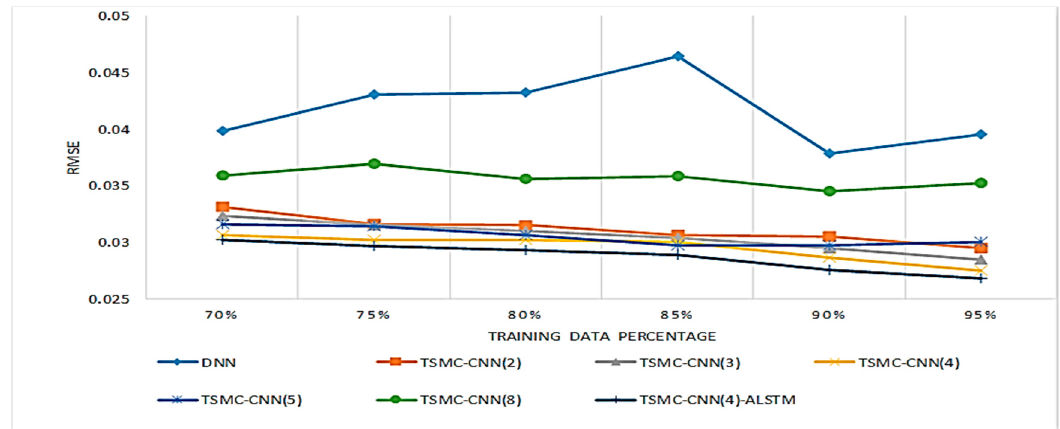
Figure 13. Comparisons of DNN, TSMC-CNN and TSMC-CNN-ALSTM with different numbers of channels in terms of the MAE.